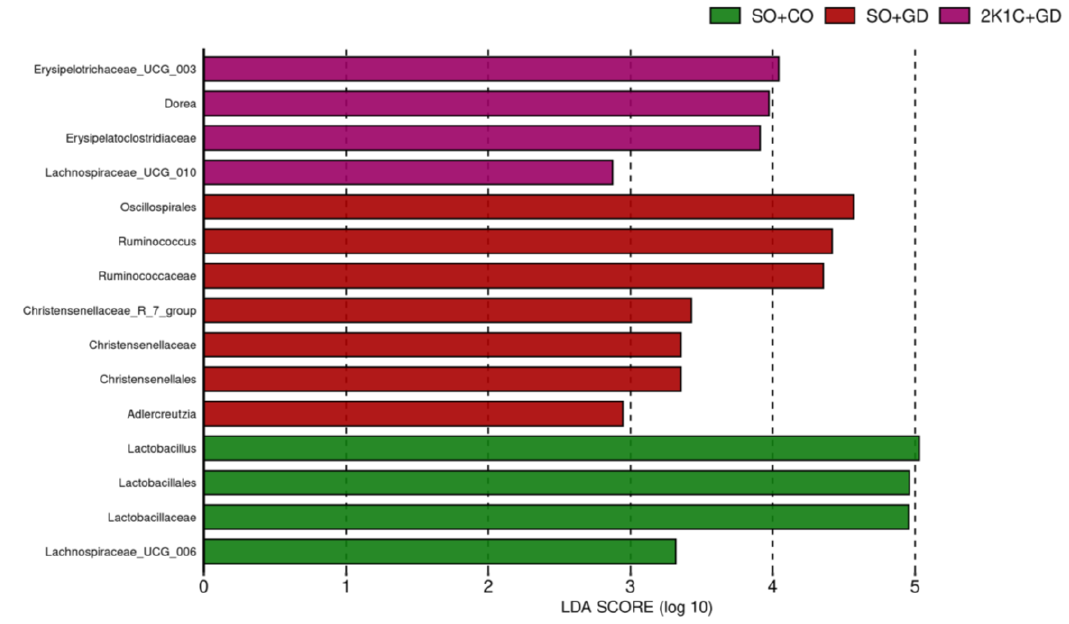
Figure 9. Linear discriminant analysis (LDA) effect size (LEfSe) bar plot representing the significant